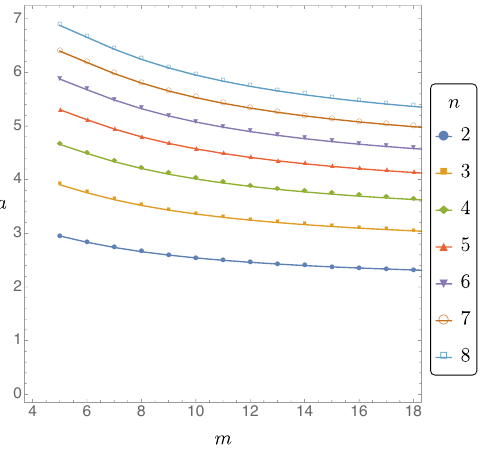
Figure 11 . Onset of superradiance for each mode m , around our pro(cid:12)le (3.23) for several values of n